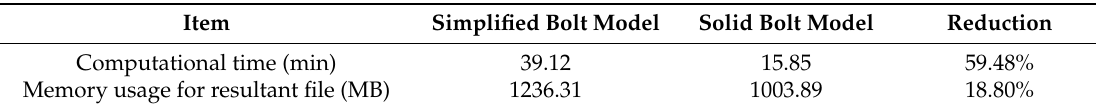
Figure 8. The maximum stress of bolts under extreme load. Table 5. Results of finite element model (FEM) analysis. Table 5. Results of finite element model (FEM) analysis.